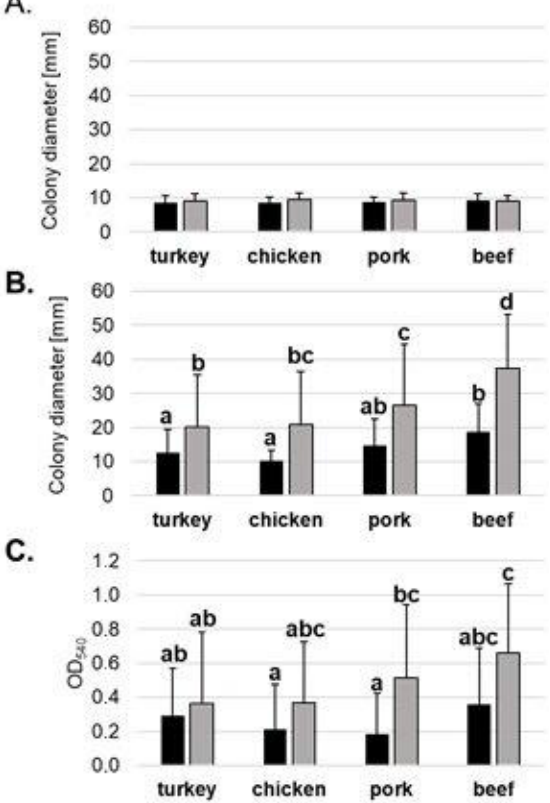
Figure 3. Swarming ( A ), swimming ( B ) and biofilm formation ( C ) ability at room temperature (black) and at 37 °C (grey) of tested cephalosporin-resistant strains isolated from meat samples. The results are presented as an average for isolated bacteria from each meat type (turkey n = 23; chicken n = 6; pork n = 7; beef n = 6). The experiment was performed twice with at least three replicates. Statistically different results are marked with different letters as tested with ANOVA followed by Tuckey post hoc test at p < 0.05.